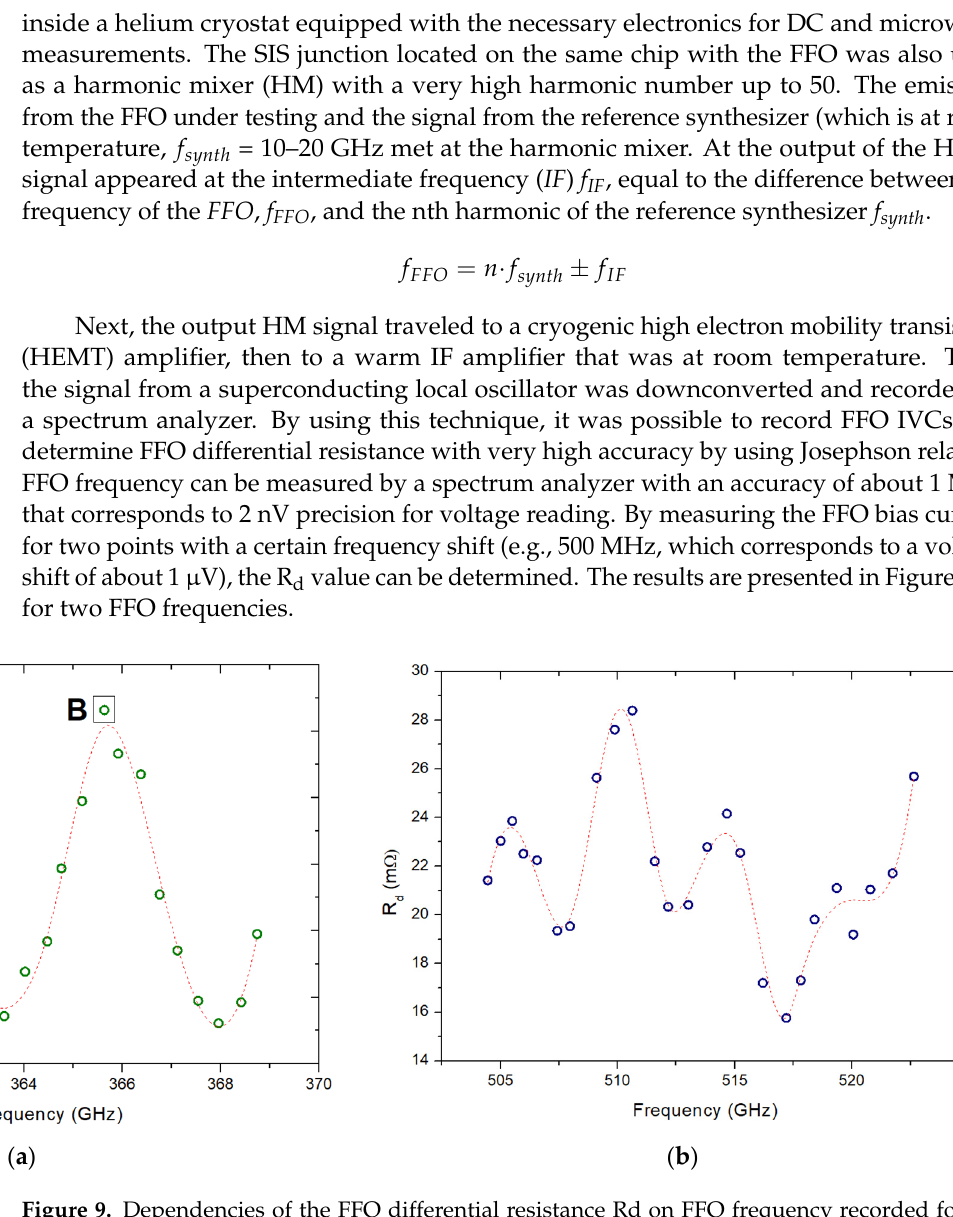
Figure 9. Dependencies of the FFO differential resistance Rd on FFO frequency recorded for the Nb-AlN-NbN junction by spectra measuring technique in two frequency ranges; near 365 ( a ) and 515 GHz ( b ). Experimental points are connected by lines as a guide for the eye.